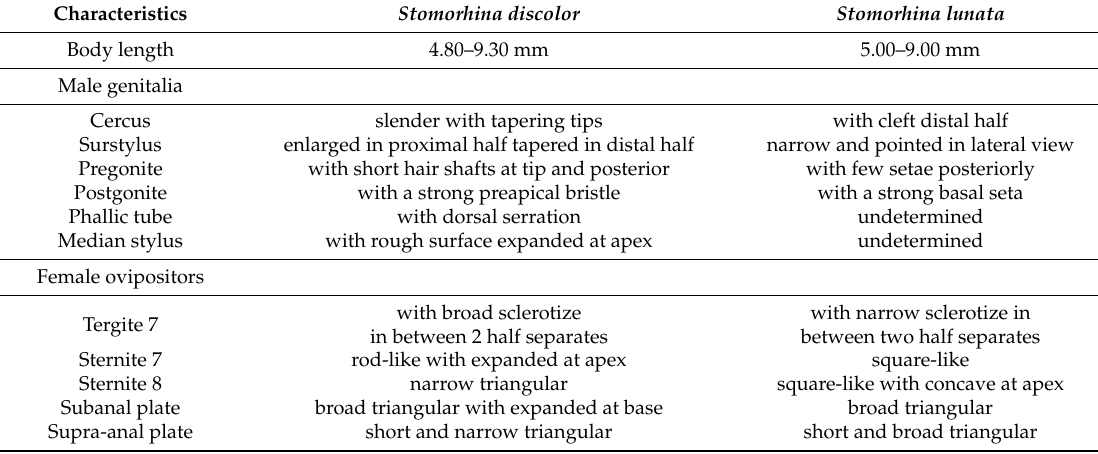
Table 1. Comparison male and female terminalia of Stomorhina discolor (current study) and Stomorhina lunata